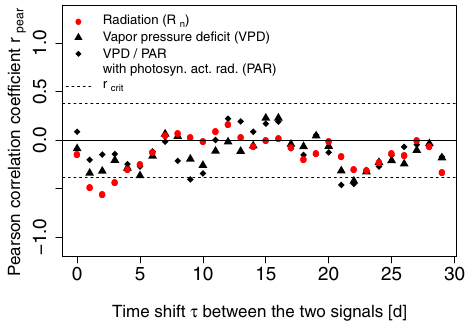
Figure 11. Pearson correlation coefficient of the isotopic composi- tion of ecosystem respiration R 13 eco C and the 2-day sum of different meteorological variables (shifted by different times τ ) before the first snow event in autumn 2015.